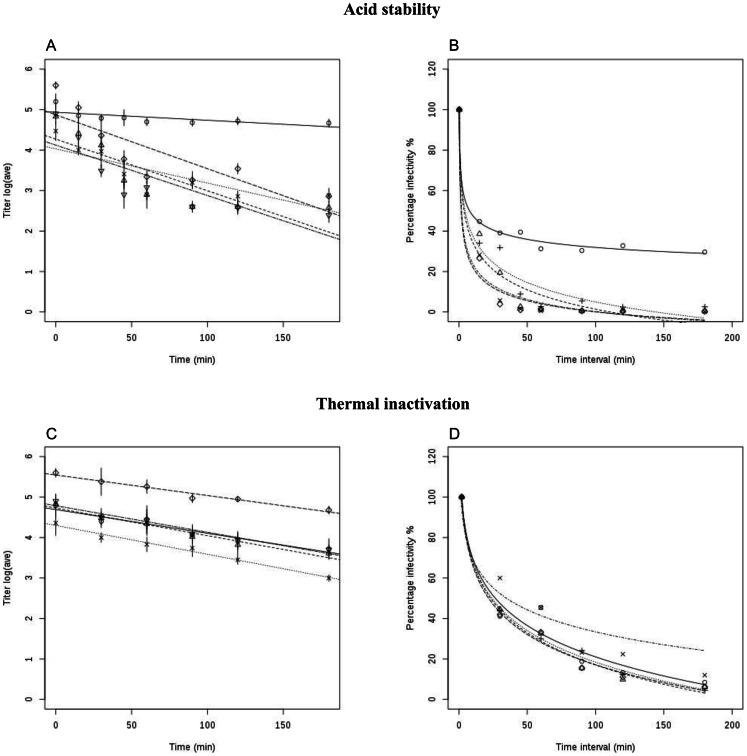
pH and thermal inactivation kinetics of vSAT2, vSAT2ZIM17-SAT2, vSAT2ZIM14-SAT2, vSAT2ZAM7-SAT2 and vSAT3ZAM4-SAT2 viruses.(A & C) Inactivation of SDG-purified vSAT2, vSAT2ZIM14-SAT2, vSAT2ZIM17-SAT2, vSAT2ZAM7-SAT2, and vSAT3ZAM4-SAT2 particles following treatment with TNE buffer at pH 6.0 (A) and heat treated at 42°C (C) for up to 3 h. The average log10 virus titers, as determined in two different inactivation experiments are shown. The respective logarithmic values of the virus titers at the different time points (0, 15, 30, 45, 60, 90, 120 and 180 min p.i.) were linearly fitted and the slopes were determined. (B & D) The average virus titers following pH treatment (B) or heat inactivation (D) were used to determine the percentage of residual infectivity over time.